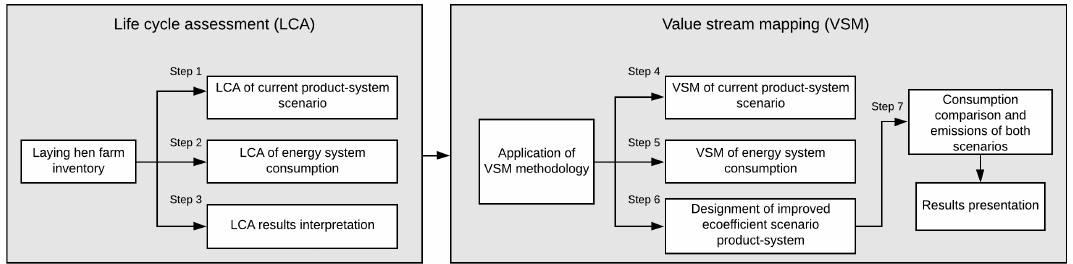
Figure 1. Work plan for the design of an eco-efficient scheme in the production of eggs in Mexico. Note: LCA, life cycle assessment; VSM, value stream mapping.